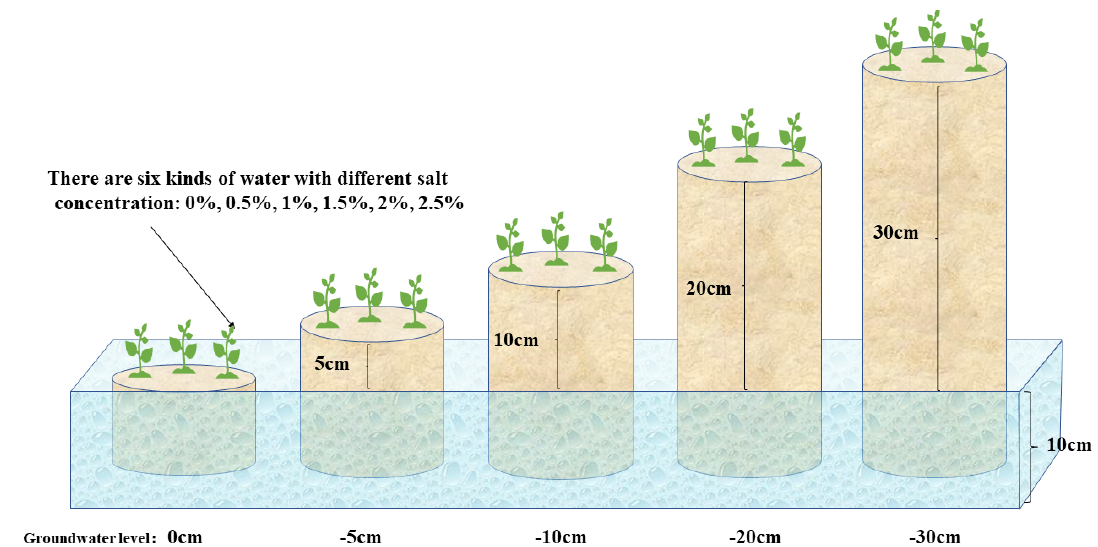
Figure 2. Schematic diagram of pot experiment scheme design.